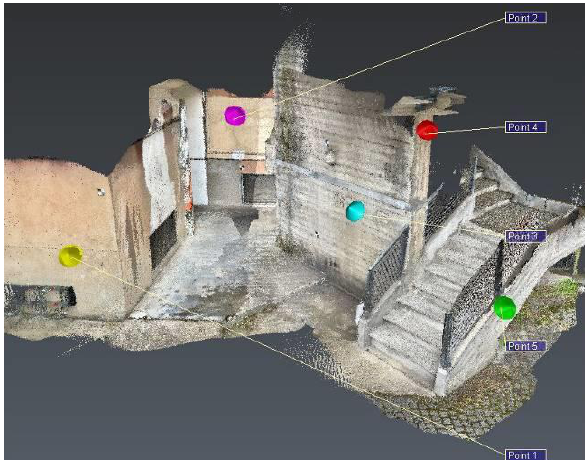
Figure 11 . GCPs collimated in the point cloud (A) to evaluate the 3D accuracy on measured points.